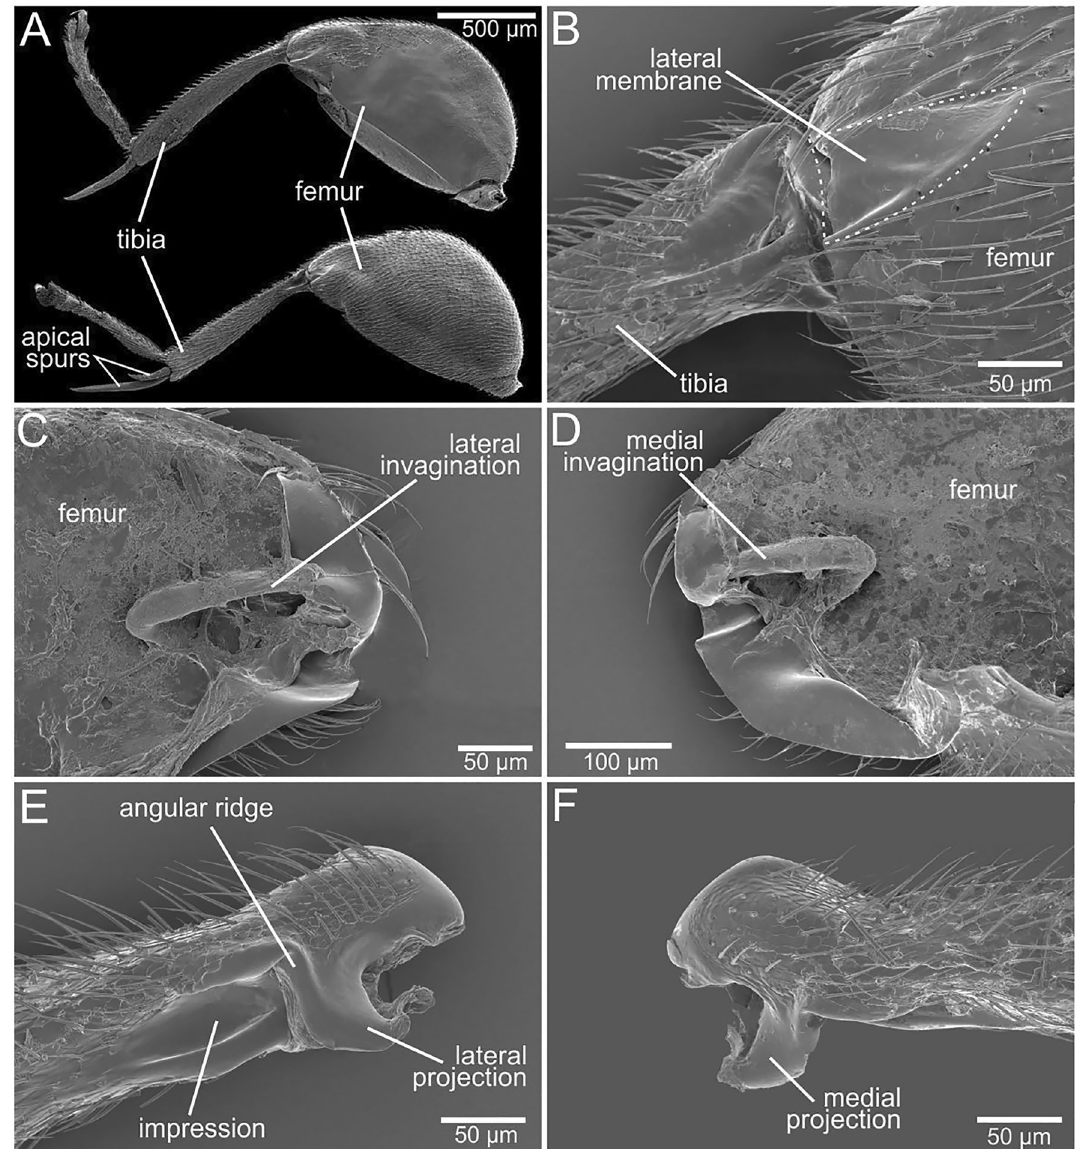
Figure 2. Structure of the jumping legs and details of the femoro-tibial joint of Scirtes hemisphaericus , scanning electron microscopy (SEM). ( A ) Hind (jumping) leg, general appearance, upper image—the medial side; bottom image—the lateral side. ( B ) Femoro-tibial joint, lateral external view, lateral membrane is outlined by dashed line. ( C , D ) Femur in the region of femoro-tibial joint, sagittal section. ( E , F ) Tibial base, antero-lateral